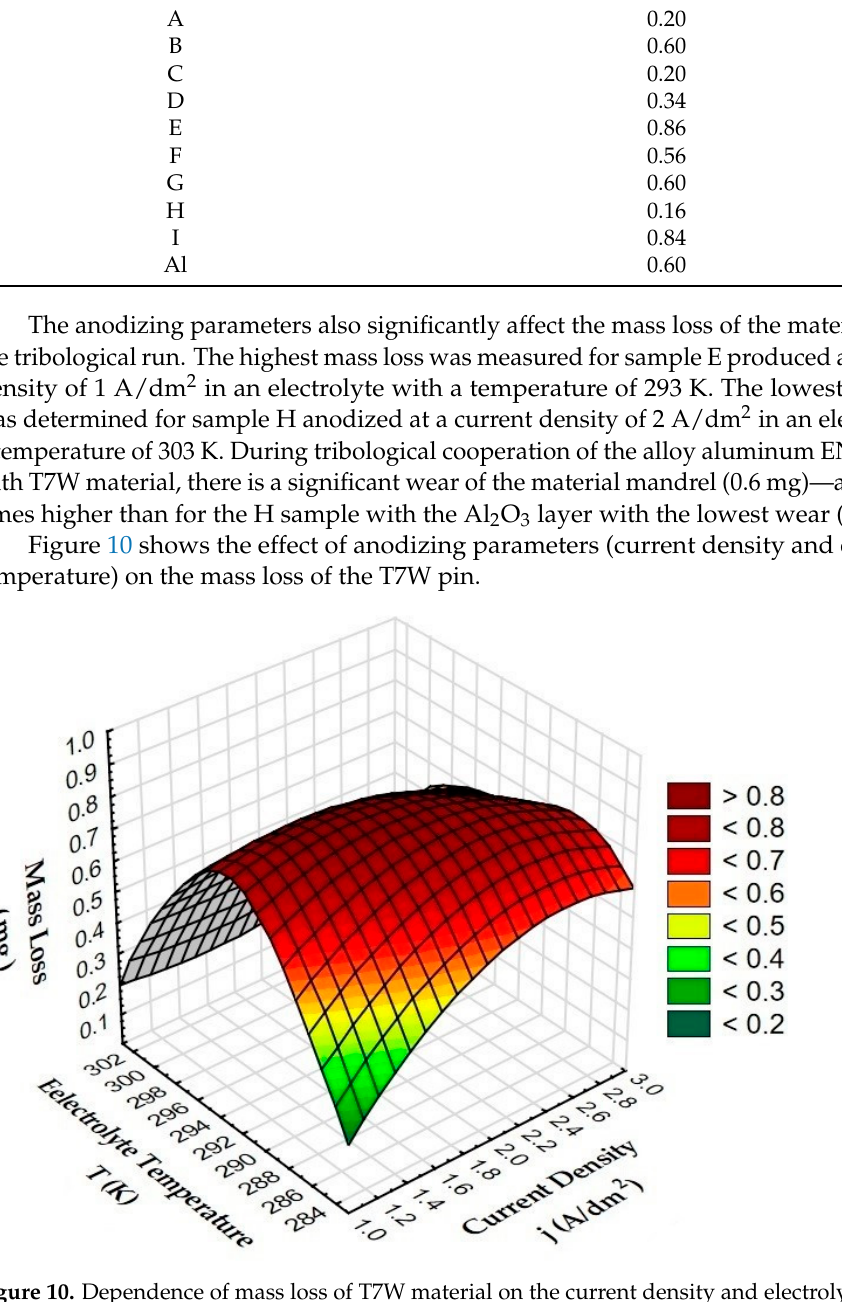
Table 4. Mass loss of the T7W mandrel in association with the samples.